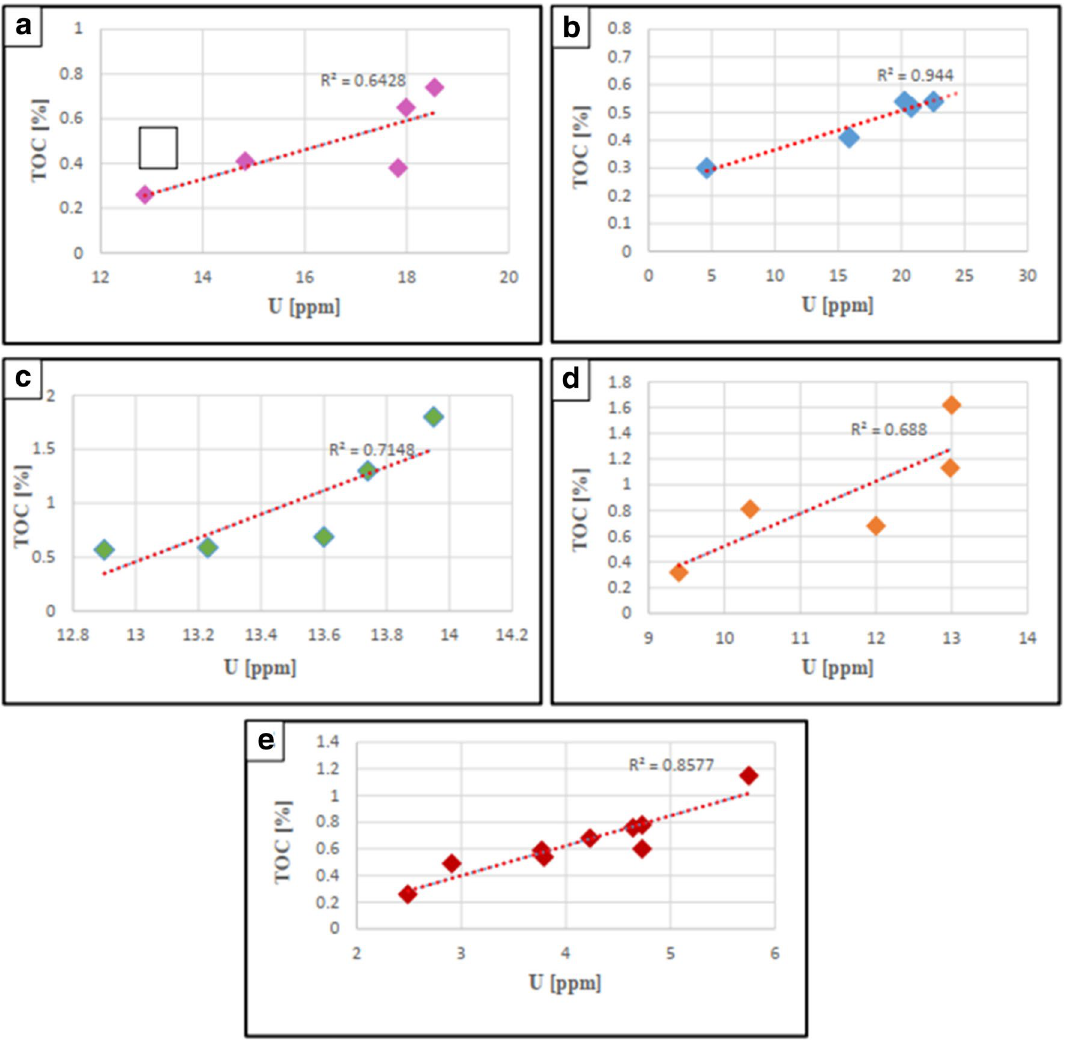
Fig. 5 TOC%/U cross plots of mudstone and shale samples in different formations a Nyalau Formation, b Tatau Formation, c Begrih Formation, d Liang Formation and e Belaga